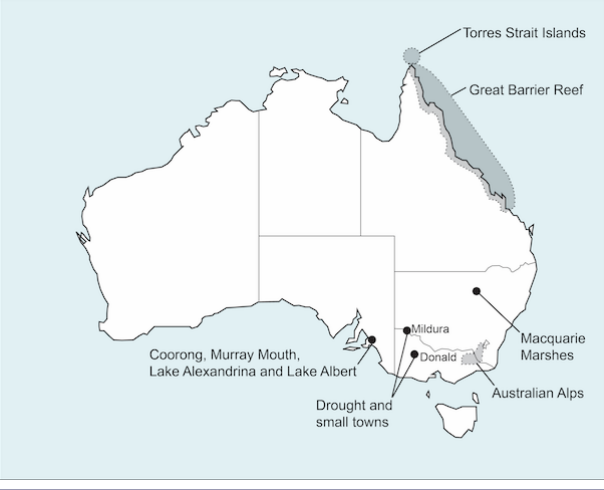
Fig. 1 . Location of the six case